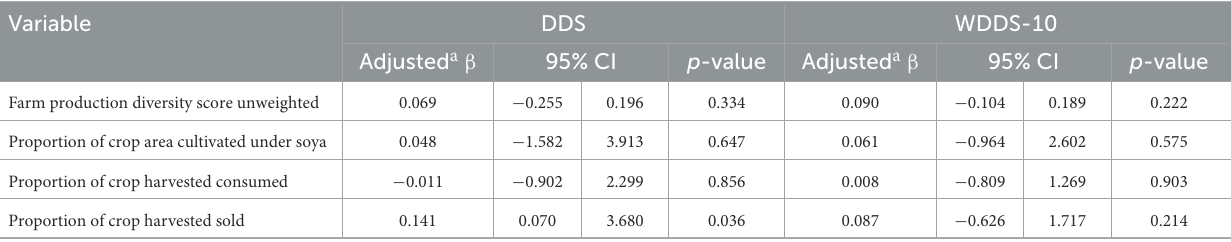
TABLE 4 Multivariate regression analysis of the relationship between dietary diversity scores (DDS) and women’s dietary diversity scores (WDDS-10) and agricultural factors. Variable